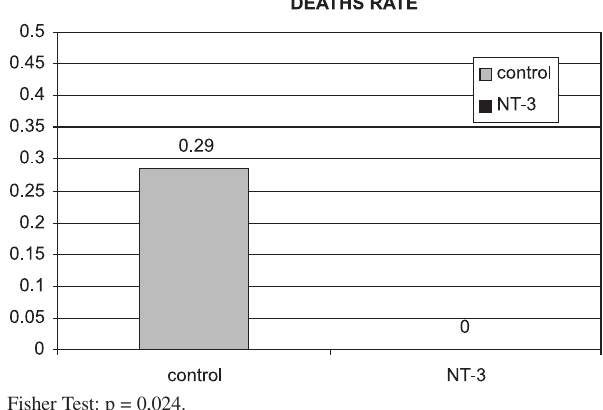
Fisher Test: p = 0,024. Figure 7 - Deaths Rate in Control and NT-3 Groups